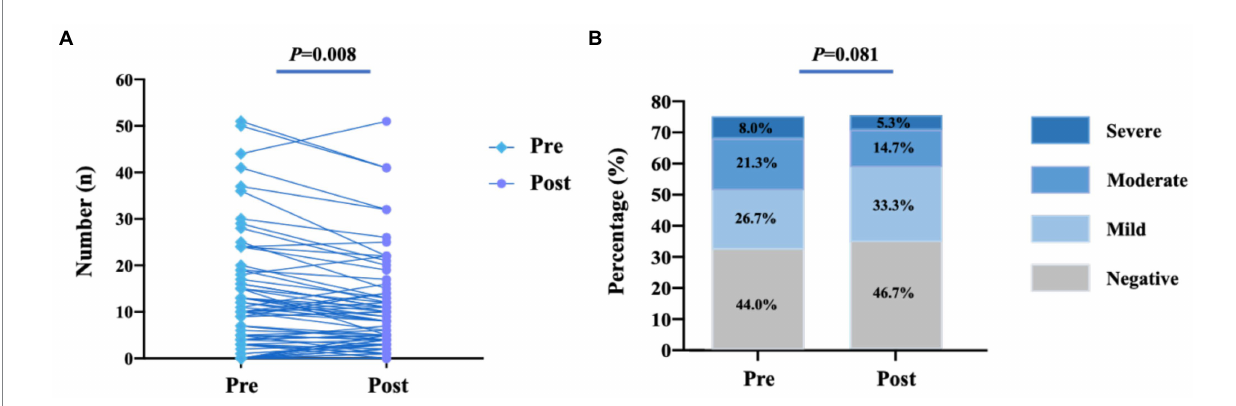
FIGURE 1 Changes of B-lines before and after the 1-min STST. (A) Number of B-lines; (B) Degree of pulmonary edema. There was significant changes in the numbers of B-lines [9 (3,16) vs. 7 (3,13), p = 0.008], while the degree of pulmonary edema ( χ 2 = 8.300, p = 0.081)was not significantly changed when compared with before the 1-min STST.